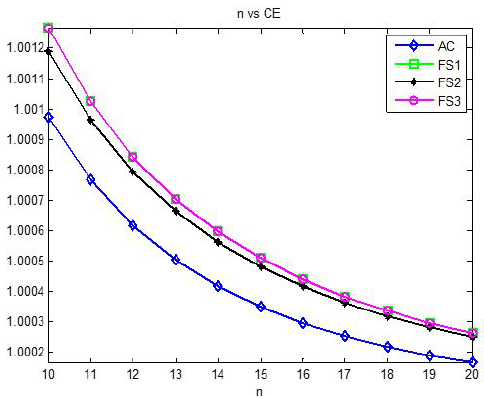
Figure 3. Comparison of Computational Efficiency for 10 (cid:54) n (cid:54)